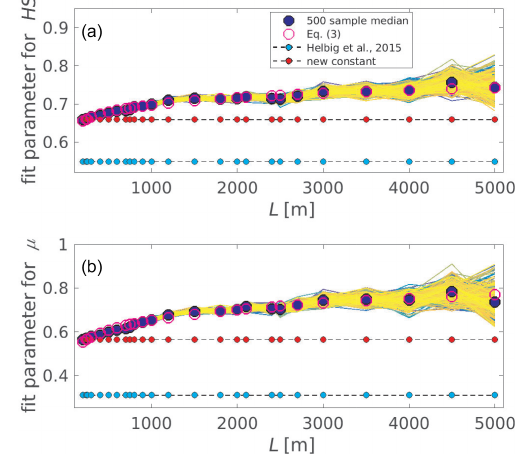
Figure 9. Fit parameters for Eq. (2) as a function of domain sizes L to scale variables (a) HS and (b) µ . Colored lines show the fit pa- rameters derived for each of the 500 random 80% samples of each of the 25 sub-data pools. The dark blue dots depict the ensemble median per L . Previously obtained constant parameters of Helbig et al. (2015) (light blue dots) and newly fitted constant (red dots), as well as newly fitted scale-dependent (pink circles) parameters are